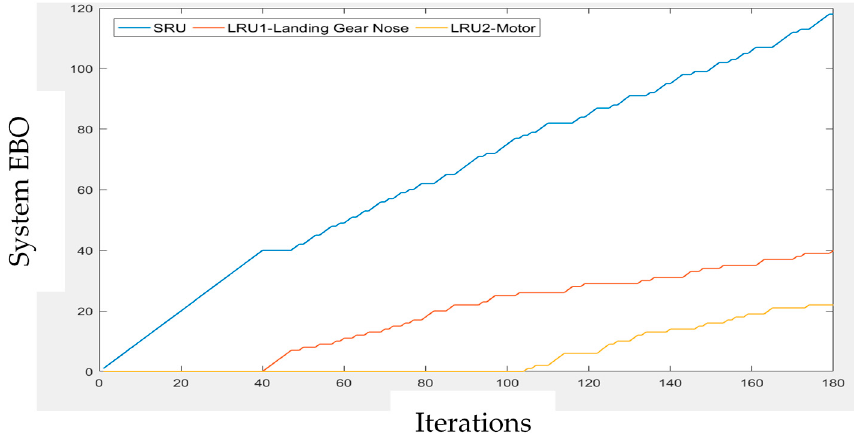
Figure 7. Component selection process.